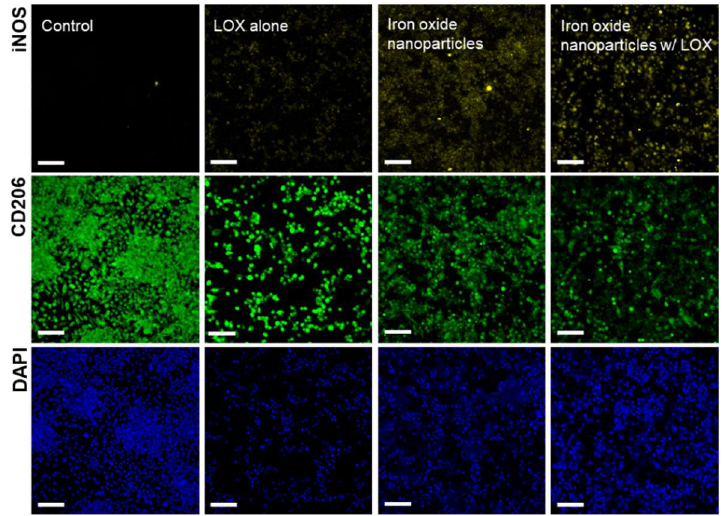
Figure 6. Distribution of macrophages under different treatments. Representative images of